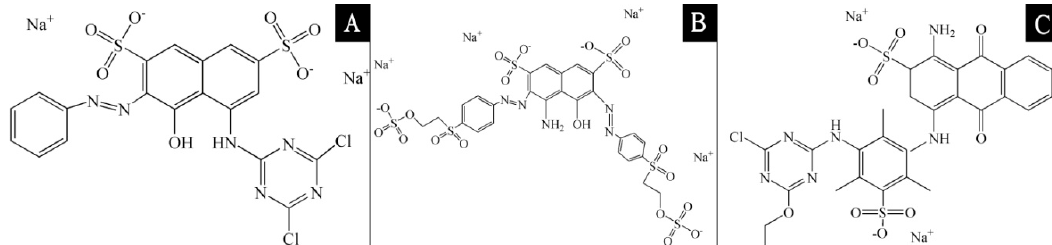
Figure 1 . The structures of ( A ) reactive brilliant red X-3B dye, ( B ) reactive black KN-B dye and ( C ) reactive blue K-3R dye.